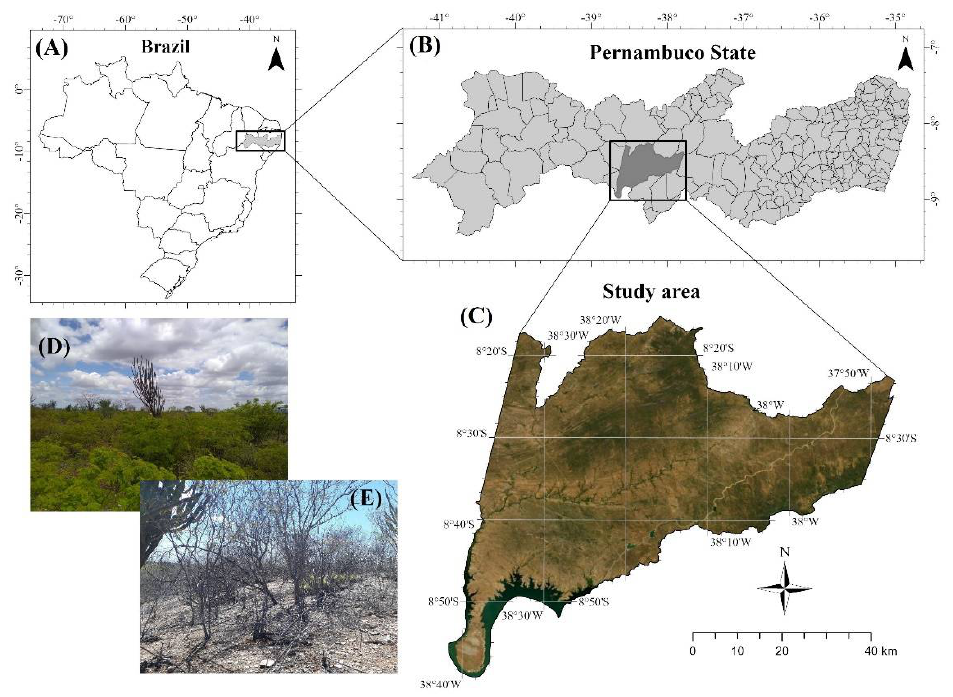
Figure 1. Coverage of the study area: ( A – C ), and photos of vegetation profiles in rainy ( D ) and dry season ( E ), in the sertão of Pernambuco, Brazil.